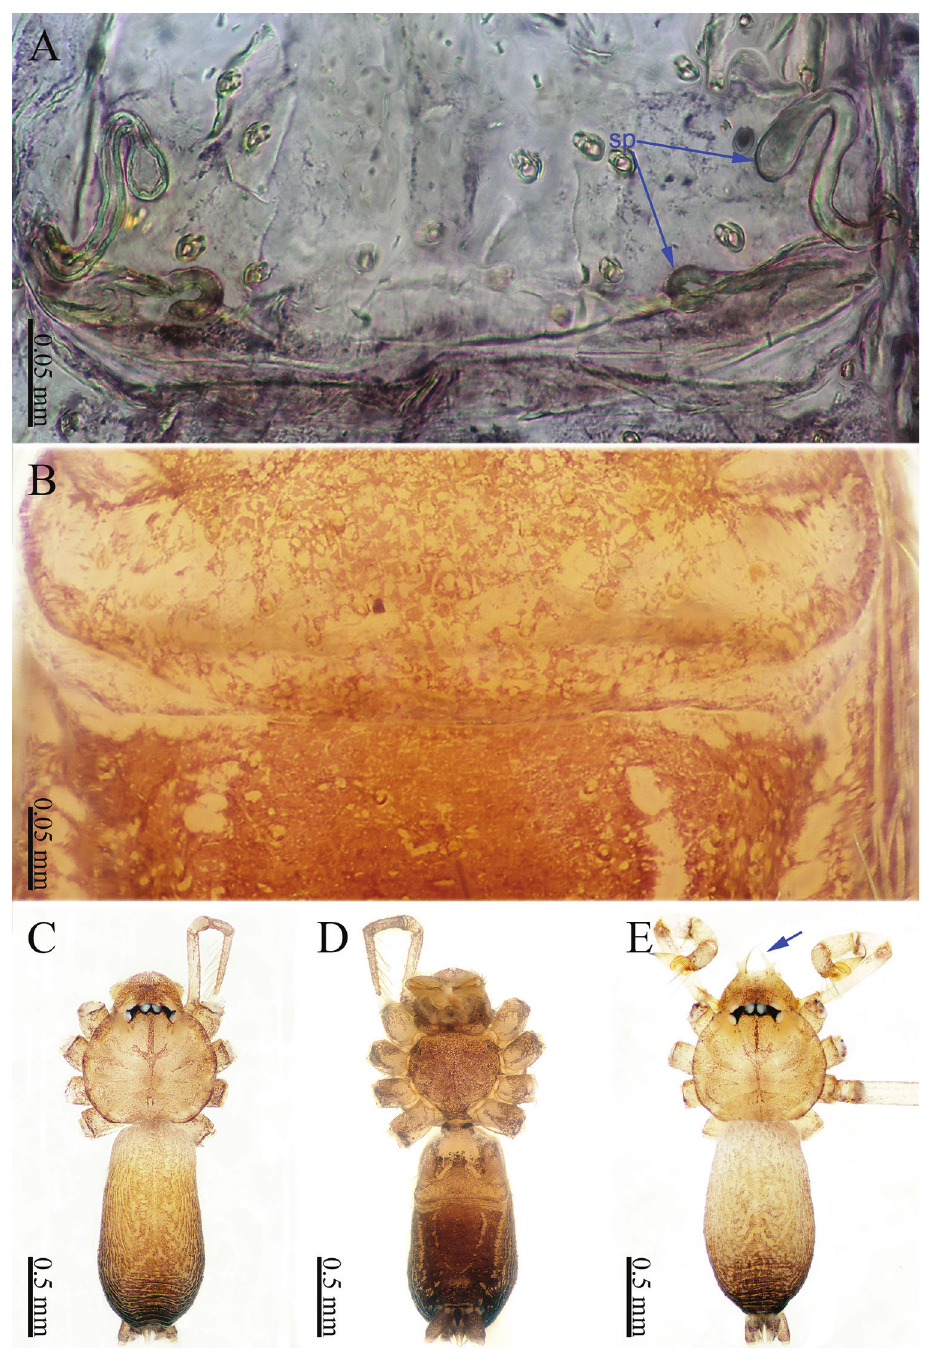
Figure 6. Sinoderces phathaoensis Li & Li, sp. nov., male holotype and female paratype A internal genita- lia, dorsal view B female epigastric furrow, ventral view C female habitus, dorsal view D female habitus, ventral view E male habitus, dorsal view (Arrow: apophysis). Abbreviation: SP